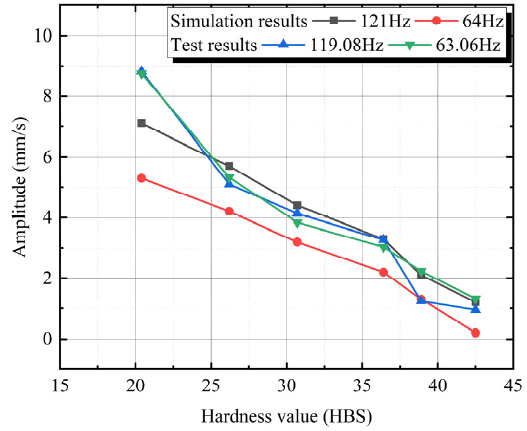
Figure 19. Hardness affects vertical vibration .